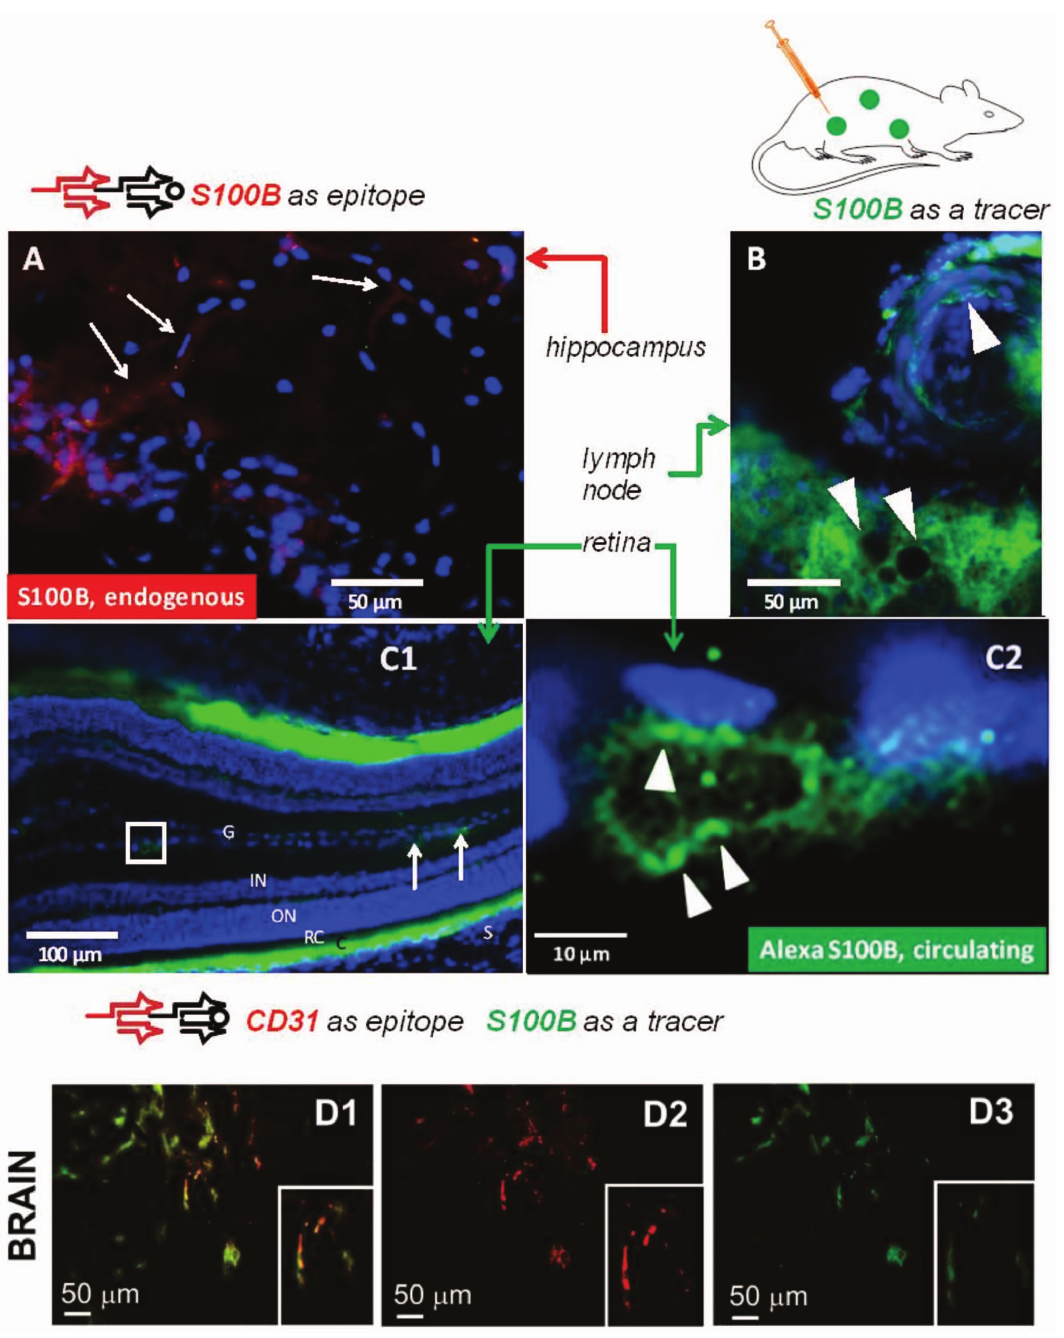
Figure 2. Endothelial cells take up circulating but not CNS-derived S100B. ( A ) Lack of significant endogenous immunoreactivity for S100B in BBB endothelial cells. The arrows point to faintly stained capillaries in the hippocampus (CA1 region). This staining was accounted for by glial end feet positive for S100B. Note the endogenous S100B immunostaining of astrocytes located within the pyramidal cell layer. ( B ) Uptake of circulating (exogenous) S100B by endothelial cells after injection of green S100B is observed in most systemic vessels. The example shows the appearance of an arteriole and capillaries in a lymph node, indicated by arrowheads . ( C1 ) and ( C2 ) show the uptake of exogenous, circulating S100B by endothelial cells of the retinal barrier. Note the uptake indicated by arrows and the various retinal layers. ( D1-3 ) Co-localization of CD31 and exogenous S100B indicates uptake by endothelial cells. Endothelial cells take up S100B after systemic injection of labeled protein. The results shown here use an immunohistochemical validation by an endothelium-specific marker to corroborate the results in Figure 1. In fact, the cells demonstrating S100B uptake ( green ) were also positive for the endothelial marker CD31. See also Figure S3 A for CNS BBB endothelial cells. G= ganglion cell layer, IN = inner nuclear layer, ON = outer nuclear layer, RC = rods and cones, C= choroid, S= sclera . AF 488-tagged S100B was injected to achieve a serum concentration of 0.12 ng/mL to mimic blood-brain barrier disruption (ref. 13).